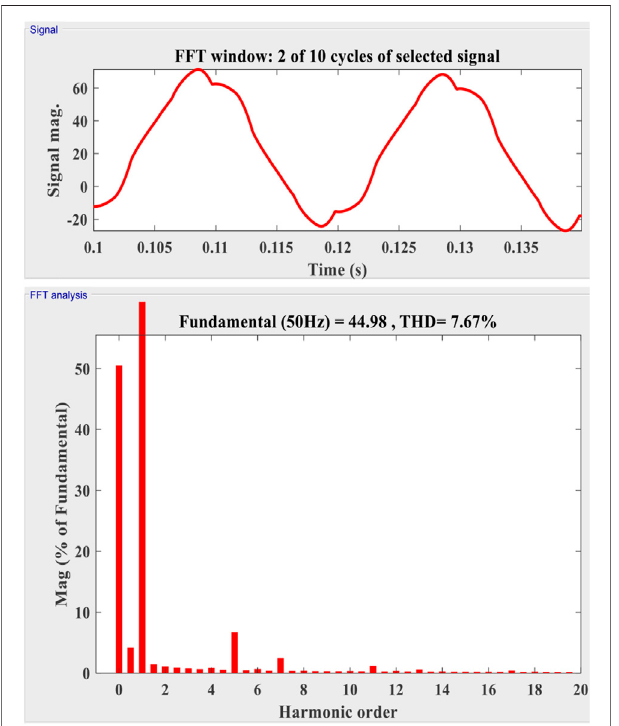
FIGURE12| Withthepassive fi lterfornonlinearloadsourcevoltage(V s ), source current (I s ), and load current (I L ).